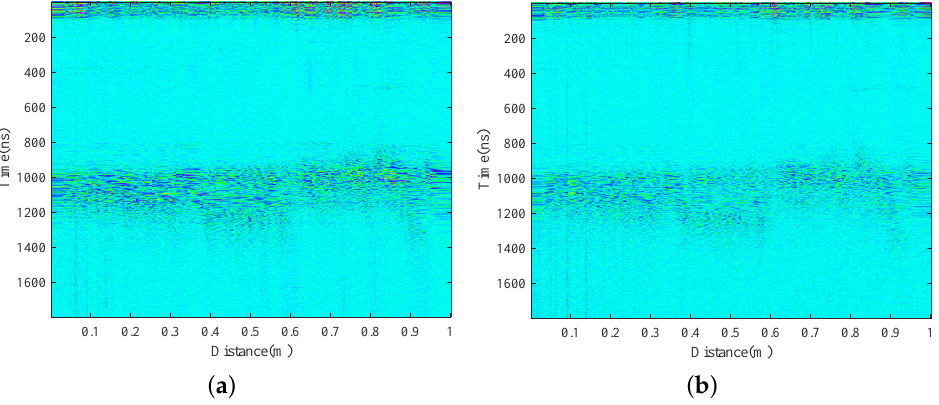
Figure 20. Glacier profiles after pre-processing. ( a ) HH polarization mode. ( b ) HV polarization